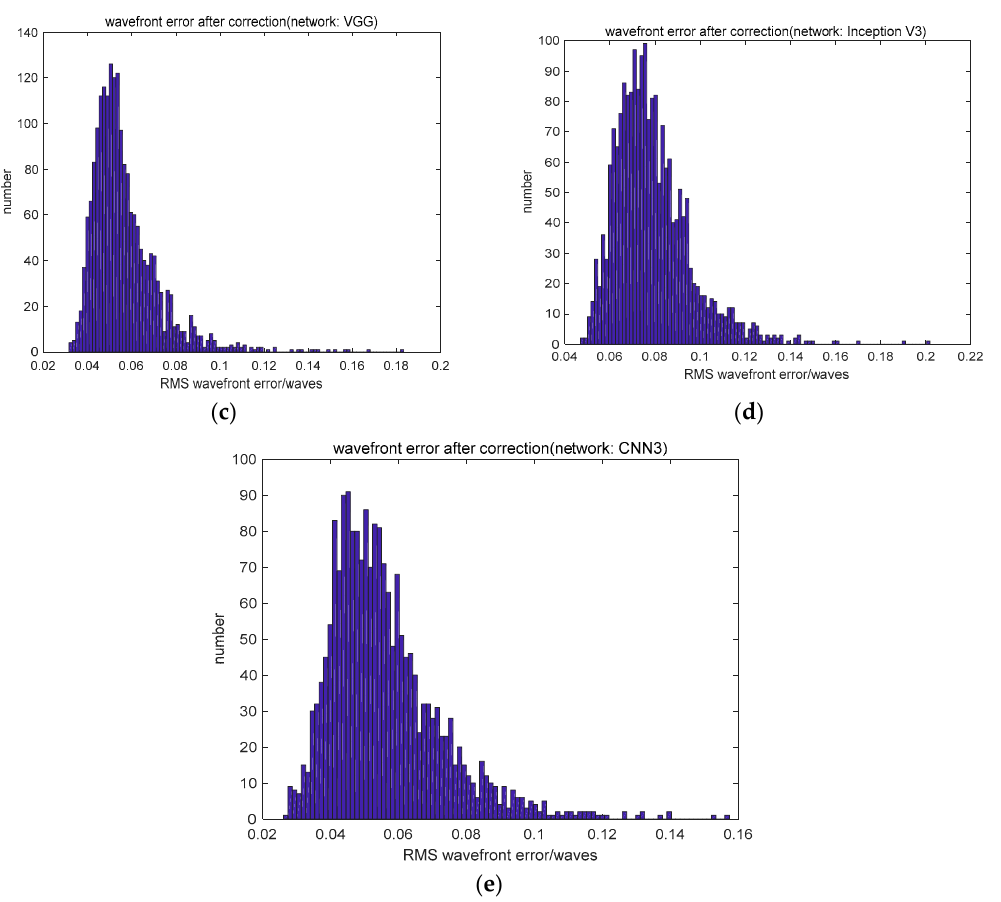
Figure 5. ( a ) The distribution of the input wavefront error and ( b – e ) the distribution of the wavefront error after correction.